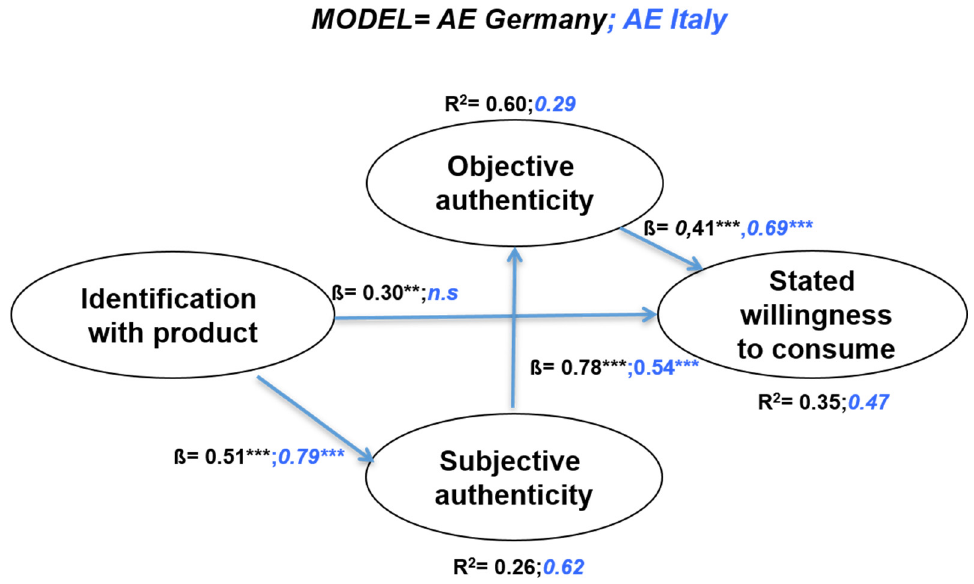
Figure 3. Results of the two structural equation models; *** = p < 0.001, ** = p < 0.01, n.s. = non statistically